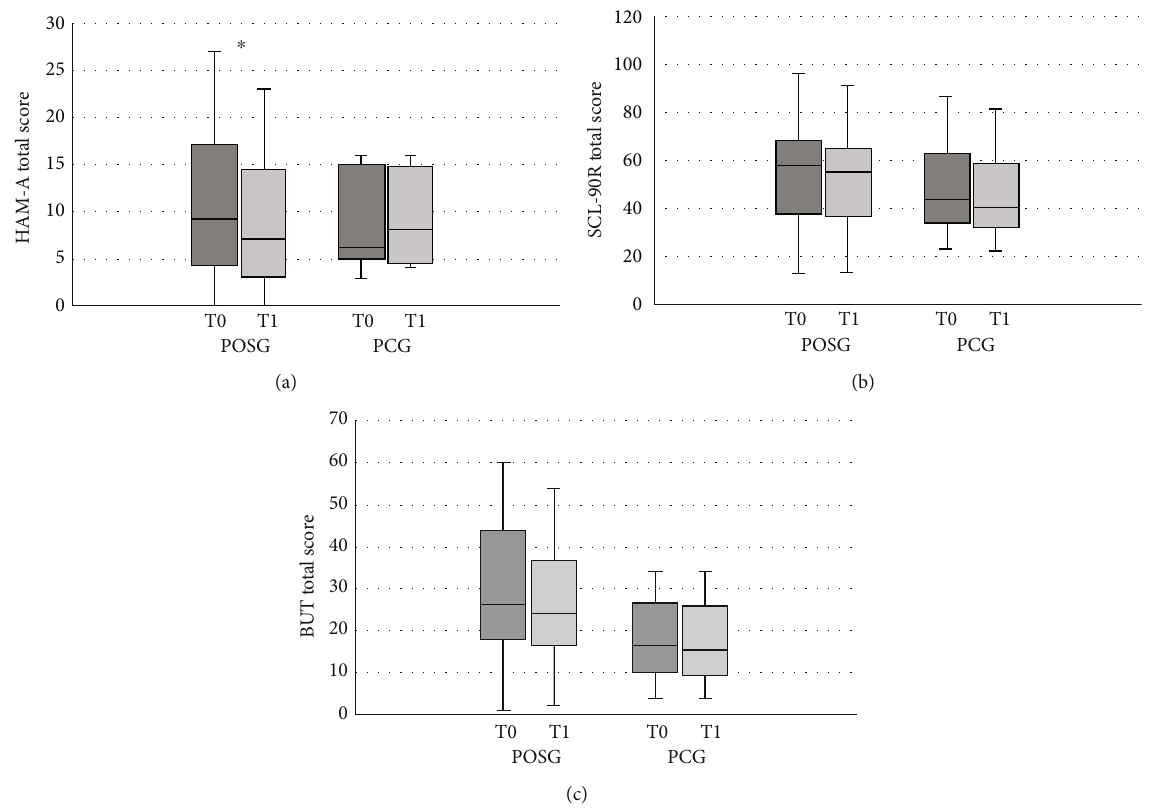
Figure 2: Comparison of psychometric test results at baseline and after treatment in POSG and PCG. Comparison of POSG and PCG before and after treatment. HAM-A: Hamilton Anxiety Rating Scale; SCL-90R: Symptom Checklist-90 Revised; BUT: Body Uneasiness Test; POSG: probiotic oral suspension group; PCG: placebo control group. Values are presented as median with min and max. Statistical signi fi cance attributed to results with ∗ p < 0 : 05